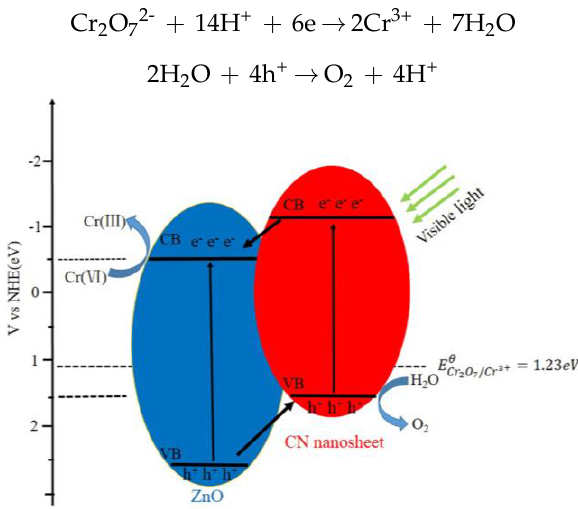
Figure 10. Schematic illustration of the mechanism of electron-hole separation and transport and photocatalytic activity of CN/ZnO photocatalyst under visible-light irradiation.